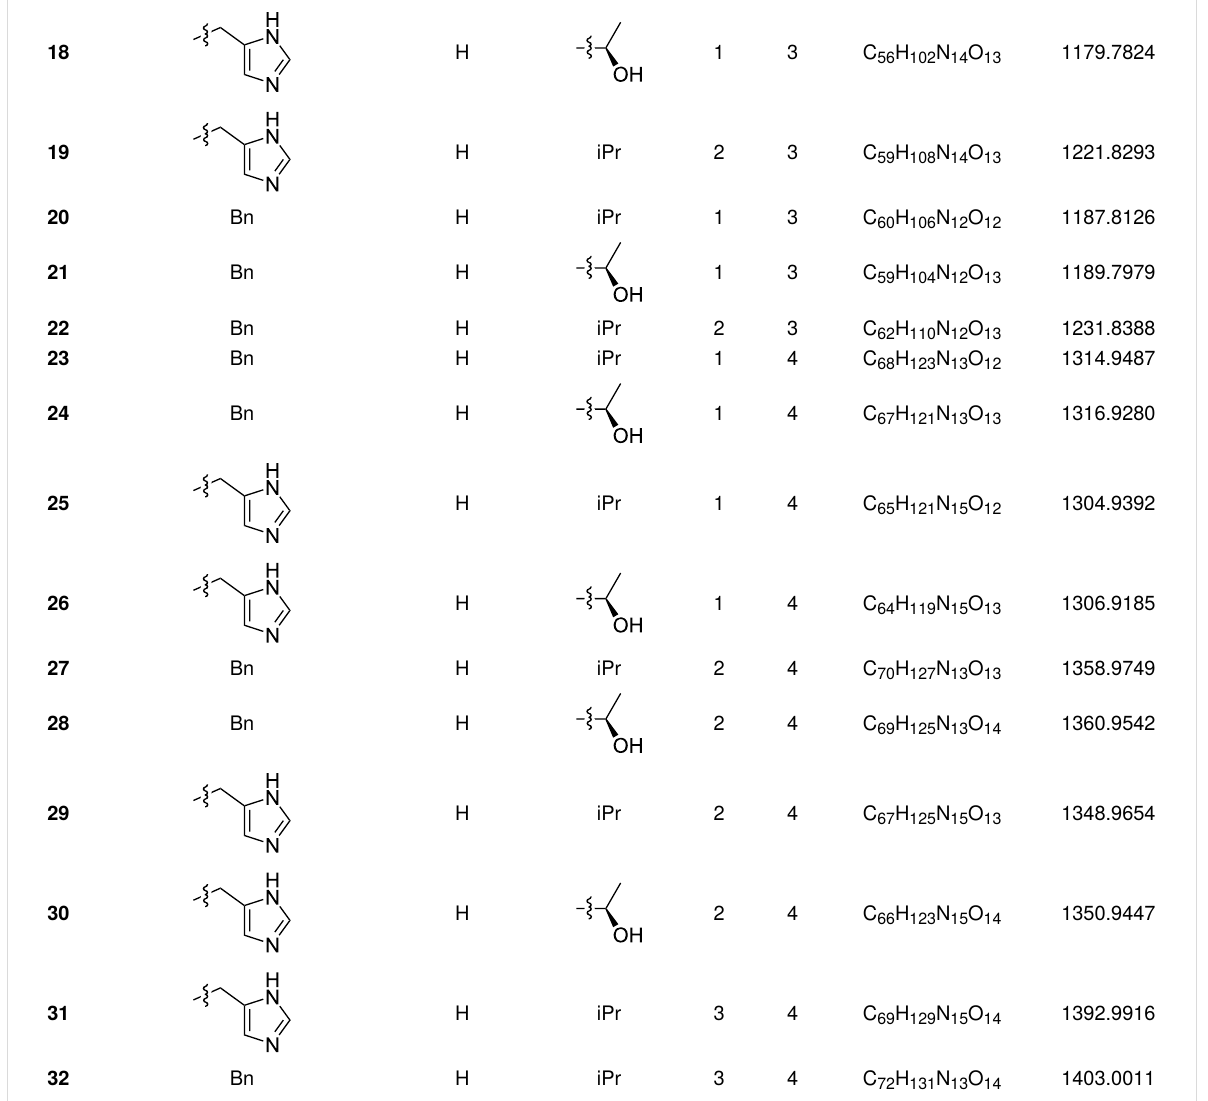
Table 1: Compound list of the fabclavine derivatives identified in this work. The structures are based on MALDI–HRMS and MALDI–MS 2 analyses using the known structure of 1 as a reference [20]. The derivatives 1 – 4 and 17 – 22 were described previously [20].